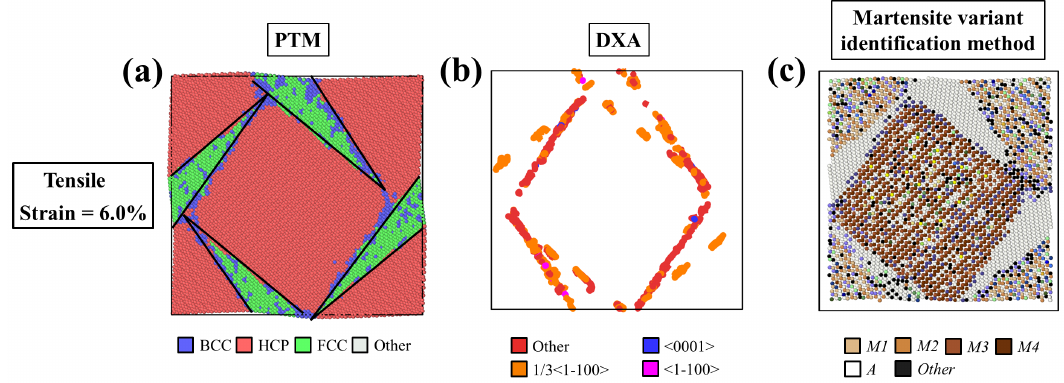
Figure 7. The self-accommodating microstructure induced at the tensile strain of 6%, visualized by ( a ) PTM, ( b ) DXA (dislocation analysis), and ( c ) the martensite variant identification